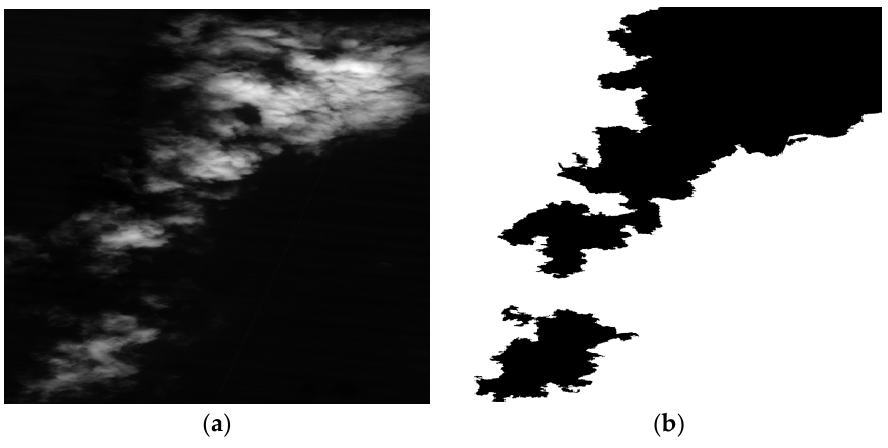
Figure 3. Land-sea segmentation result of the sea covered by thick clouds. ( a ) The original image; and ( b ) the result of land-sea segmentation.